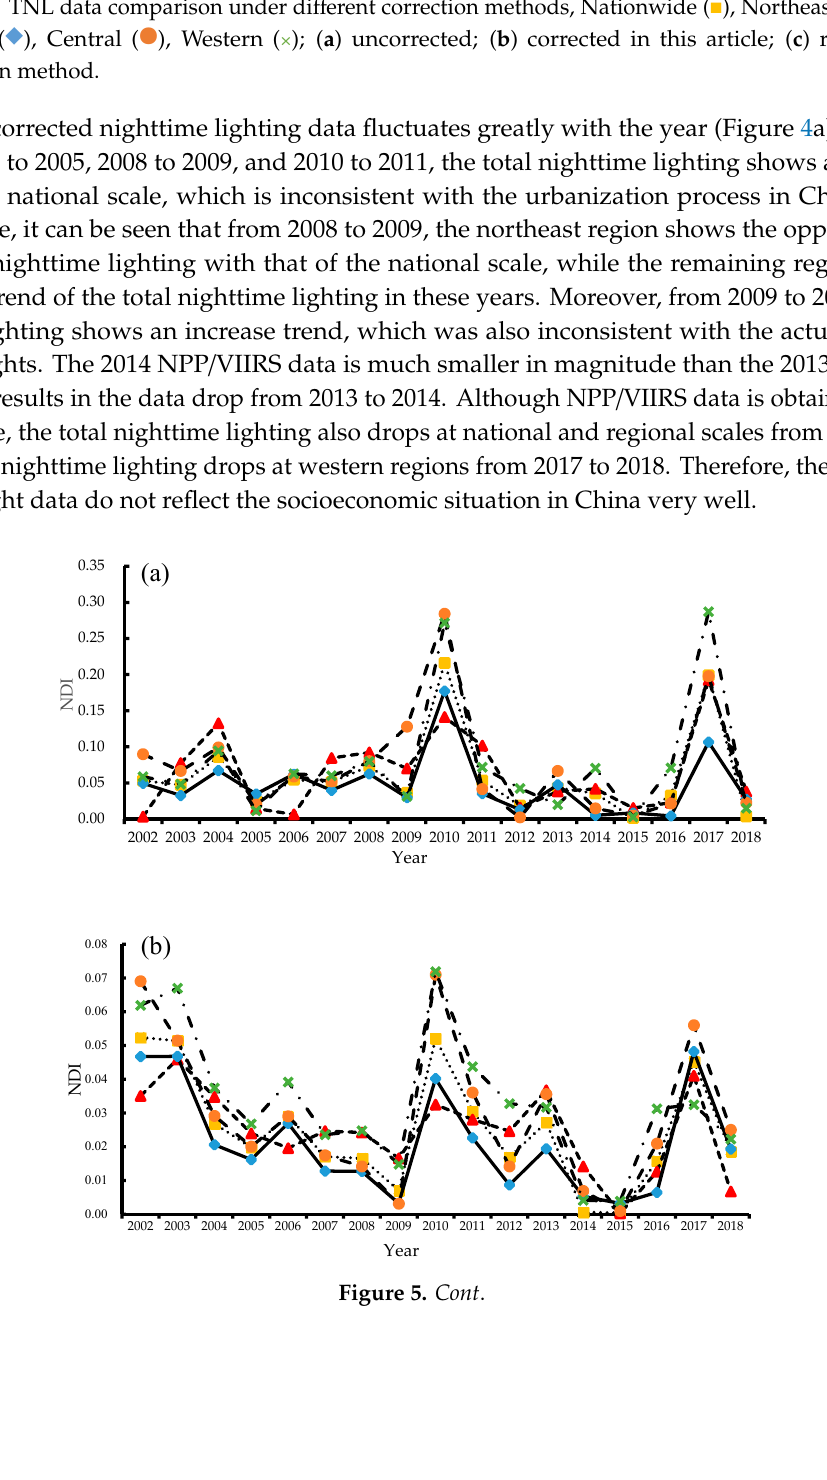
Figure 4. TNL data comparison under different correction methods, Nationwide ( ■ ), Northeastern ( ▲ ), Eastern ( ◆ ), Central ( ● ), Western (×); ( a ) uncorrected; ( b ) corrected in this article; ( c ) reference correction method.